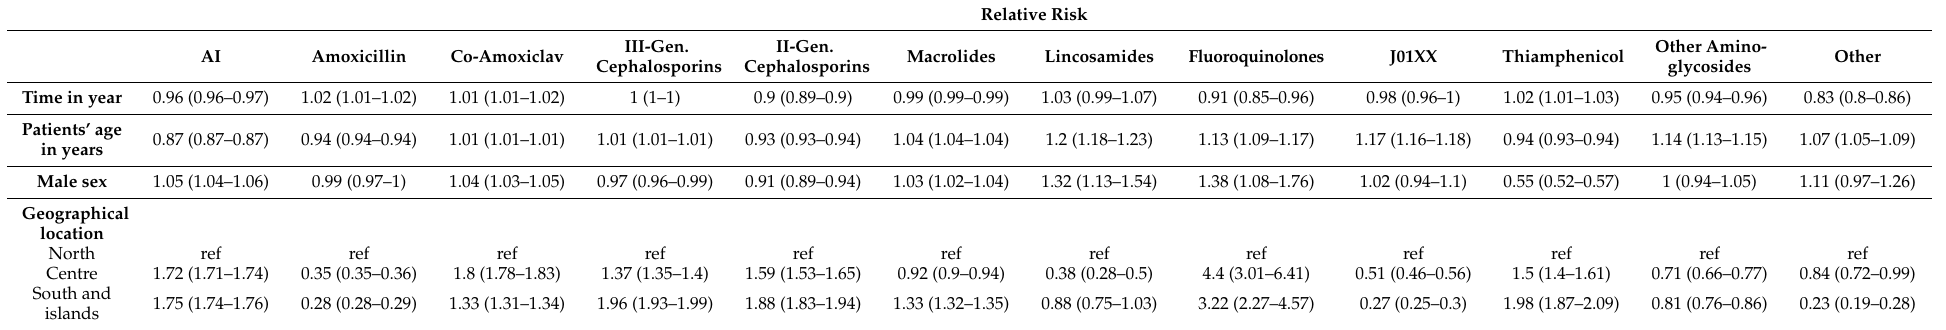
Table 1. Antibiotic index relative rate and antibiotic prescription relative rate by class with 95% CI adjusted for calendar year, patients’ age, sex, and geographical location (Pedianet